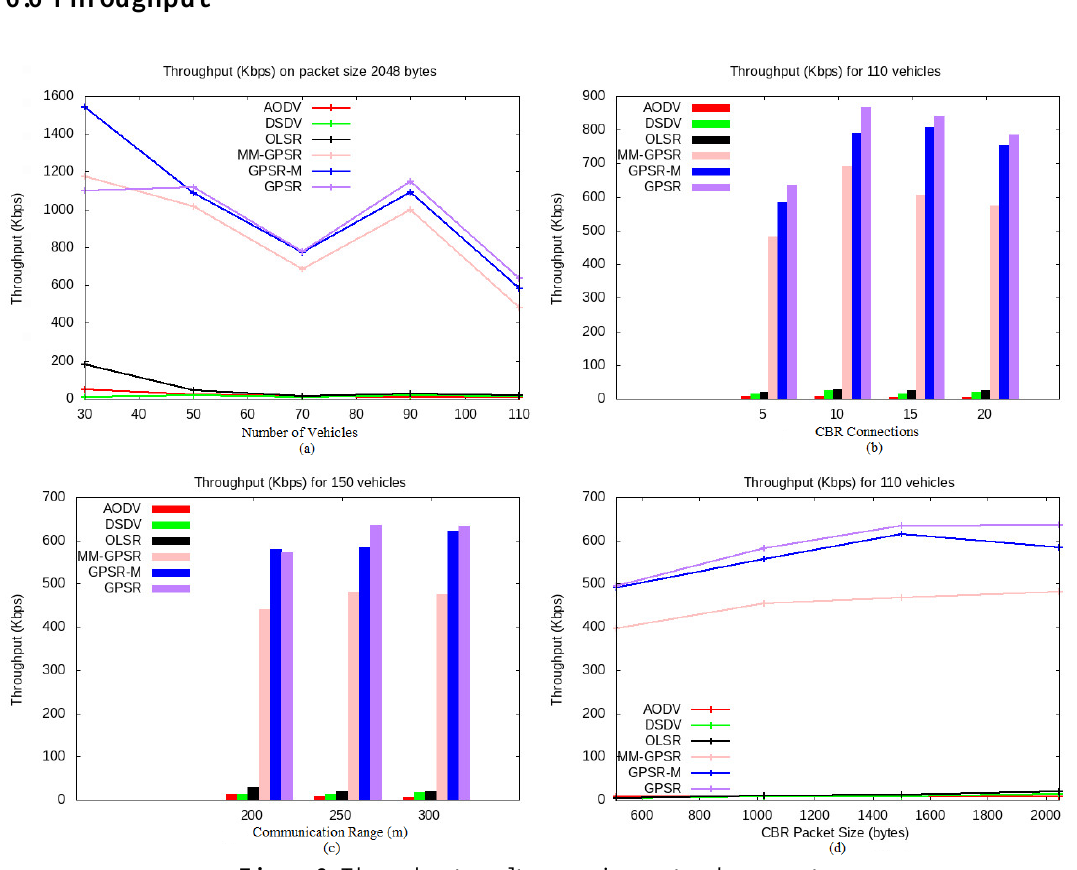
Figure 9. Throughput results on various network